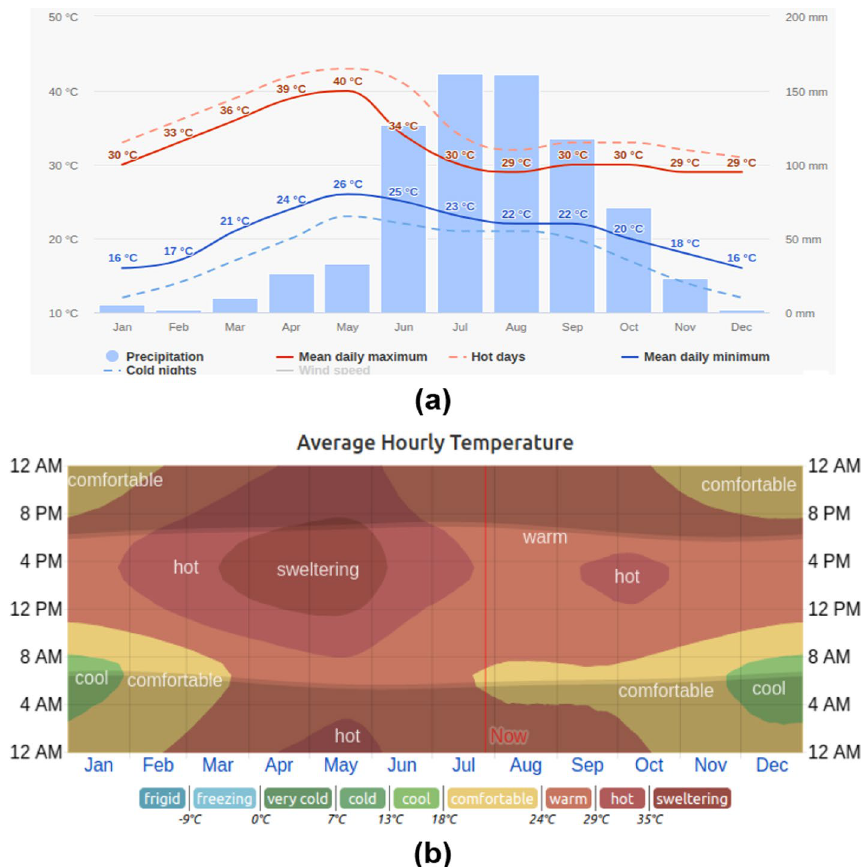
Table 1 Homes considered for analysis using energy bills Number of HIG Number of MIG Number of LIG AC homes 6 8 5 Non-AC homes 1 1